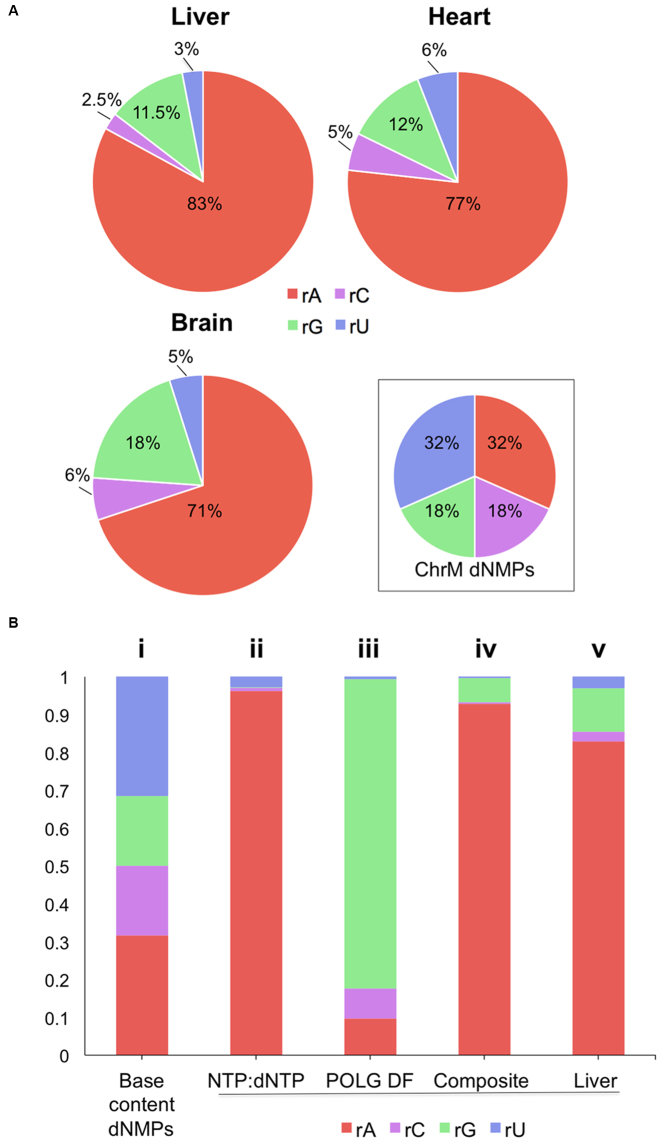
rAMP is the dominant ribonucleotide in mtDNA of murine solid tissues, the combined result of nucleotide concentrations and the properties of POLG. (A) The proportion of each of the embedded rNMPs in murine liver, brain and heart mtDNA and the base composition of the ‘primary sequence’ of the mouse mitochondrial genome (ChrM). (B) Expected proportions of embedded rNMPs if the sole determinant were: (i) the mtDNA base composition, (ii) the rNTP/dNTP ratio in liver mitochondria (derived from (20)),  (iii) the discrimination factor (DF) of the mitochondrial DNA polymerase (POLG) (derived from (21)), both adjusted for the mtDNA sequence; or (iv) if rNMP incorporation was a function of both the POLG DF and the rNTP:dNTP ratio. This ‘composite’ is most similar to the observed proportions for liver (v).